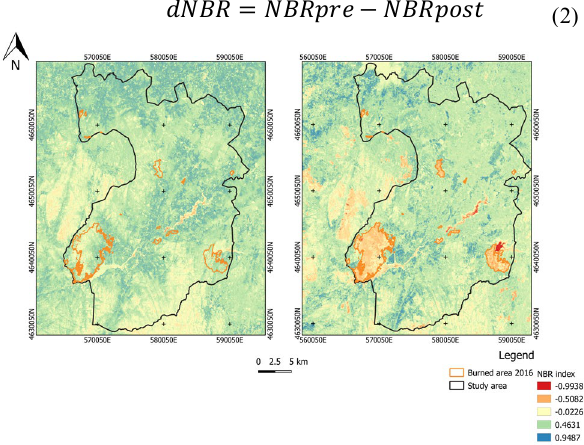
Figure 2 . NBR pre-fire (left) and NBR post fire (right) 2016 year.